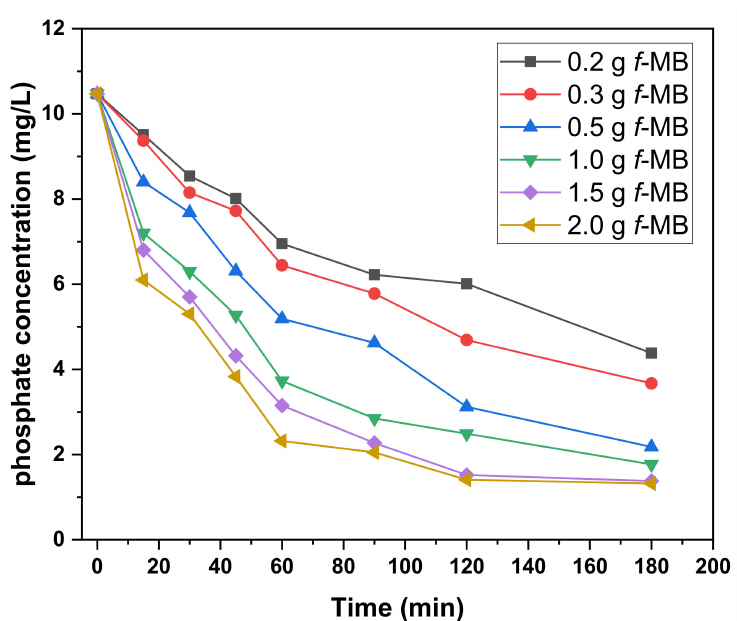
Figure 7. Phosphate adsorption from DWW exposed to different amounts of f -MB (0.2–2 g). Phos- phate initial concentration: 10.47